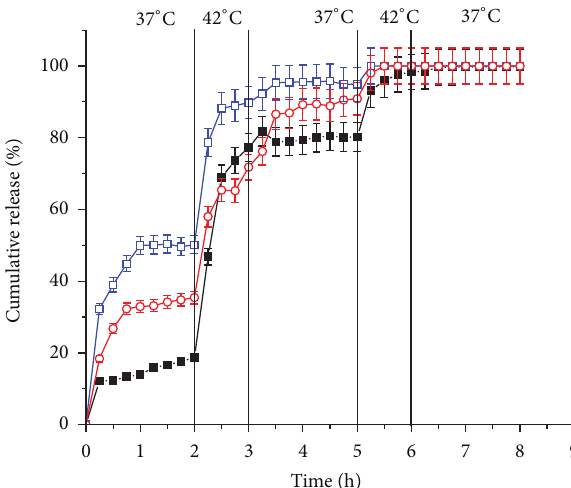
Figure 7: Release of 5-fluorouracil from different star polymers at constant temperatures: free 5-fluorouracil in PBS at pH 6 at 37 ∘ C ( I ) and at pH 7.4 at 37 ∘ C ( ◼ ) and at 42 ∘ C ( ◻ ); star polymer [poly(NIPAAm- co -4MBA)- b -polyHA] 1 -EGDMA 10 in PBS at pH 6 at 37 ∘ C ( e ) and at pH 7.4 at 37 ∘ C ( 󳶃 ) and at 42 ∘ C ( 󳶚 ); star polymer [polyNIPAAm- b- polyHA] 1 -EGDMA 10 in PBS at pH 7.4 at 37 ∘ C ( 󳵳 ) and 42 ∘ C ( 󳵻 ).